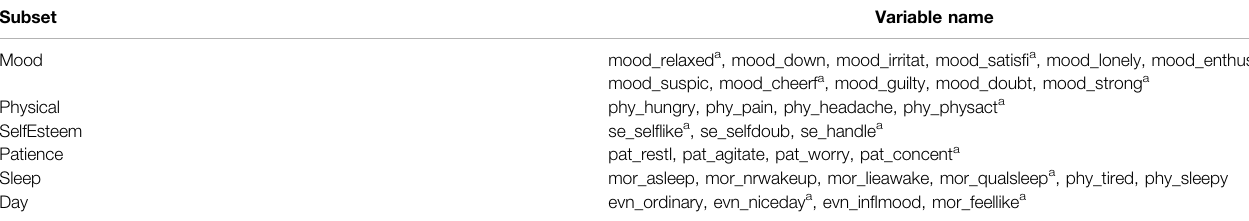
TABLE 2 | Variables used to construct Recurrence